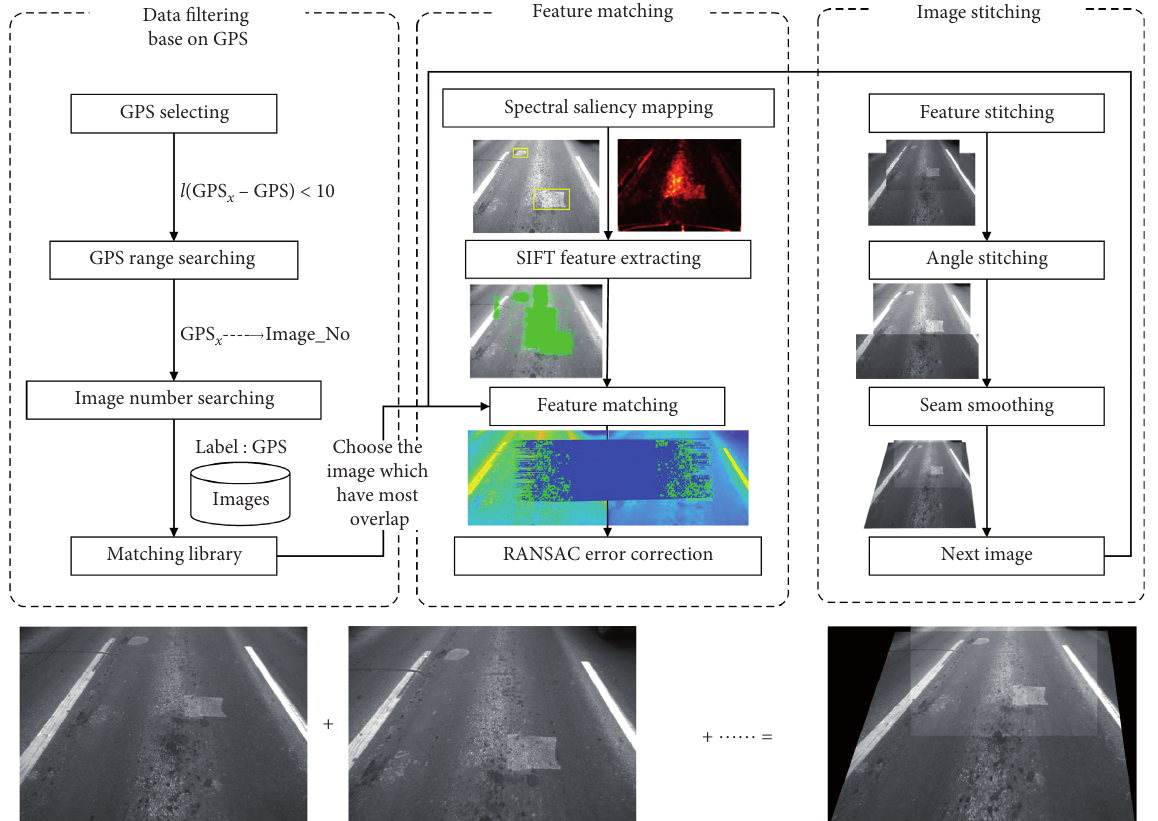
Figure 4: The pavement distress image-stitching